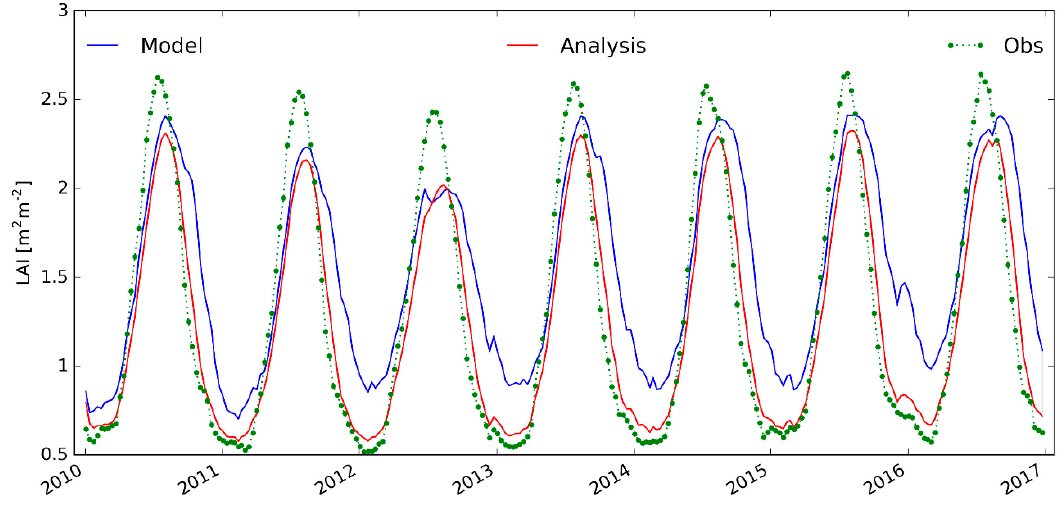
Figure 2. Leaf area index time series from the model (blue line), the observations (green dots and dashed line), and the analysis (red line) averaged over the whole domain from 2010 to 2017.